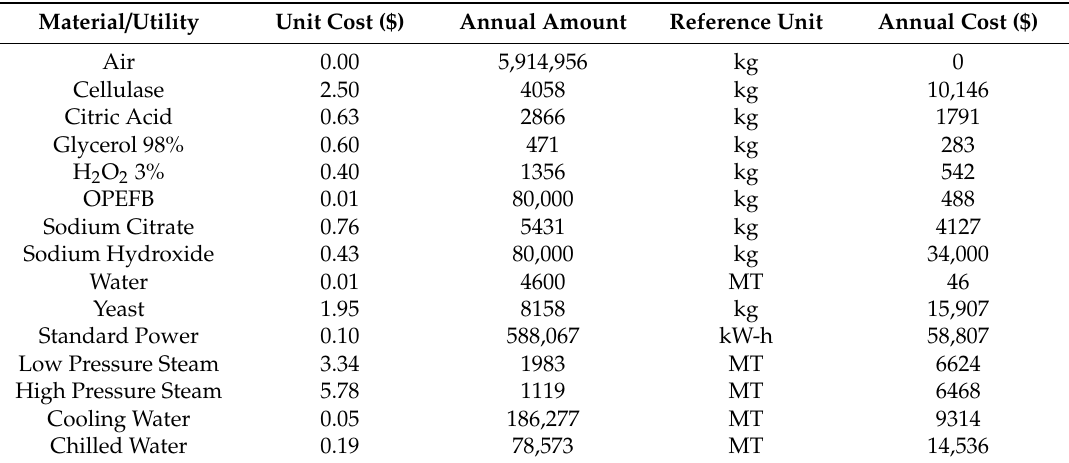
Table 6. A detailed list of materials and utilities cost.